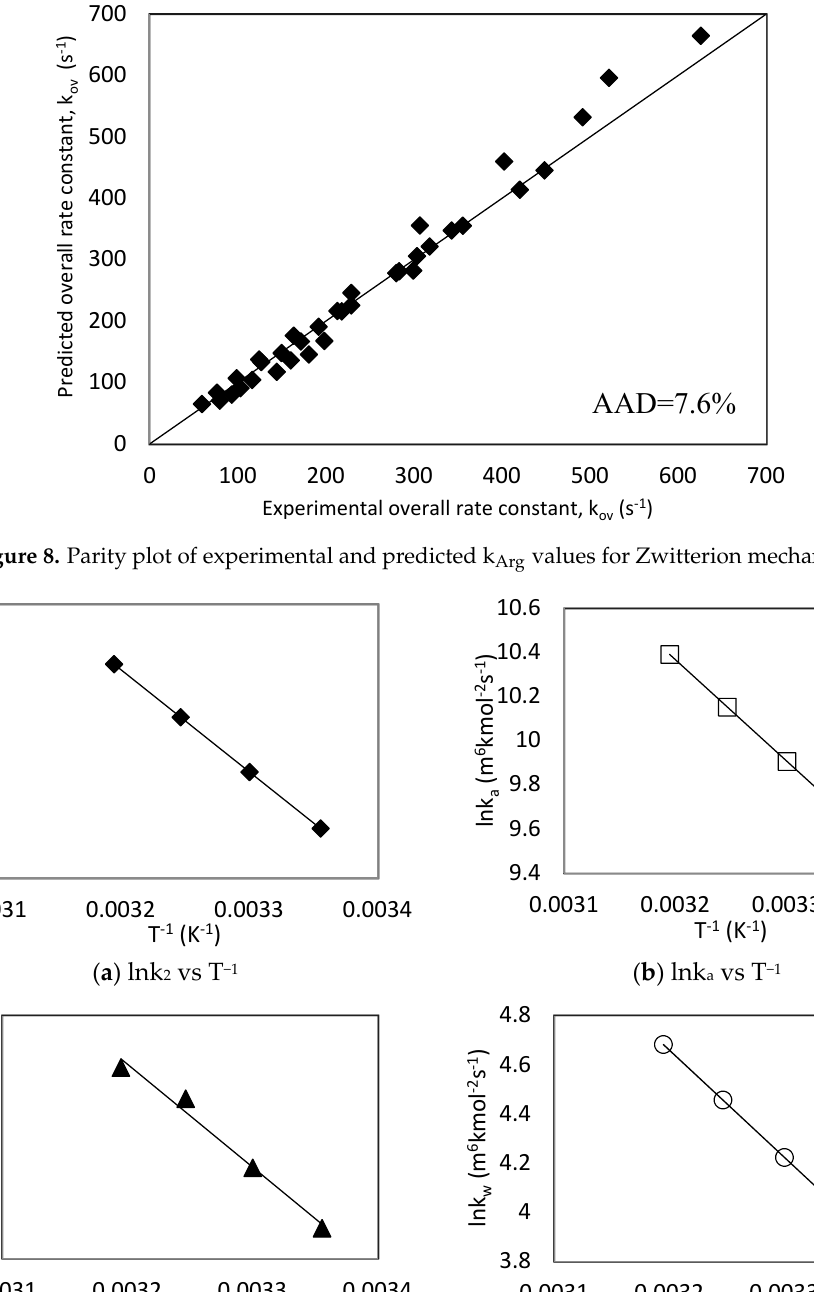
Figure 9. Arrhenius plots of CO 2 -MDEA-Arg rate constants using zwitterion mechanism.